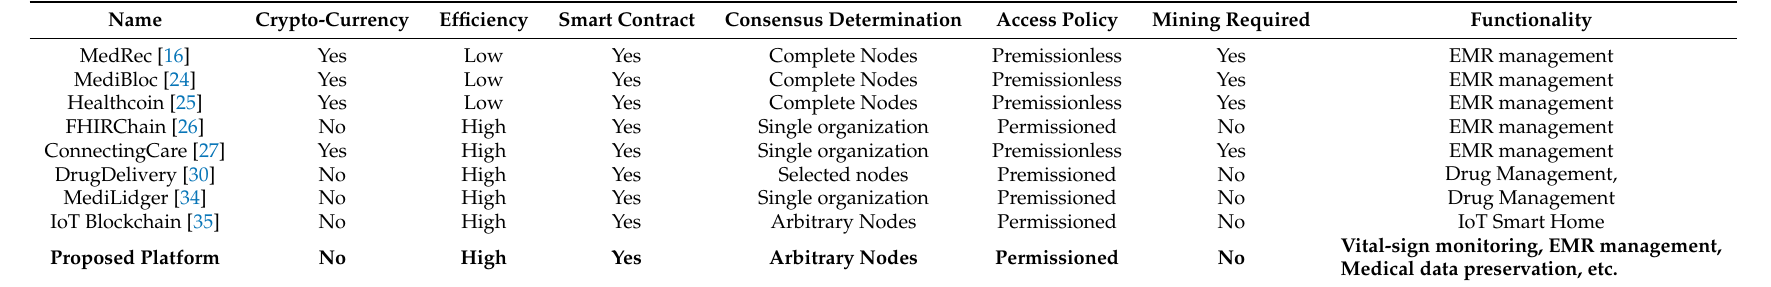
Table 7. Comparative analysis with existing